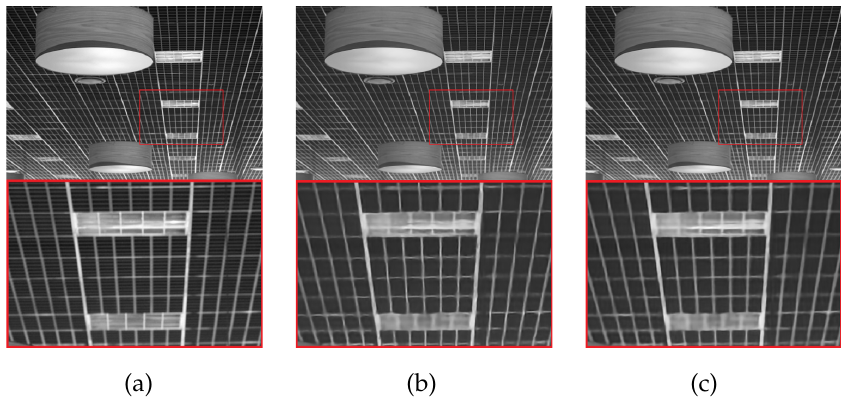
Figure 6. Super-resolution image reconstruction results. ( a ) Ground truth image. ( b ) The result of the VDSR method (PSNR = 29.34 dB). ( c ) The result of the proposed method (PSNR = 30.31 dB).